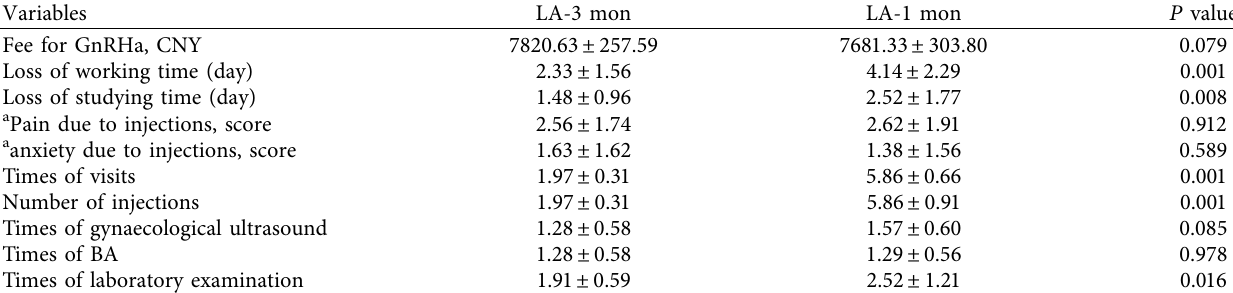
Table 5: Evaluation of economic psychology for the LA 3-month depot and 1-month depot in half a year.